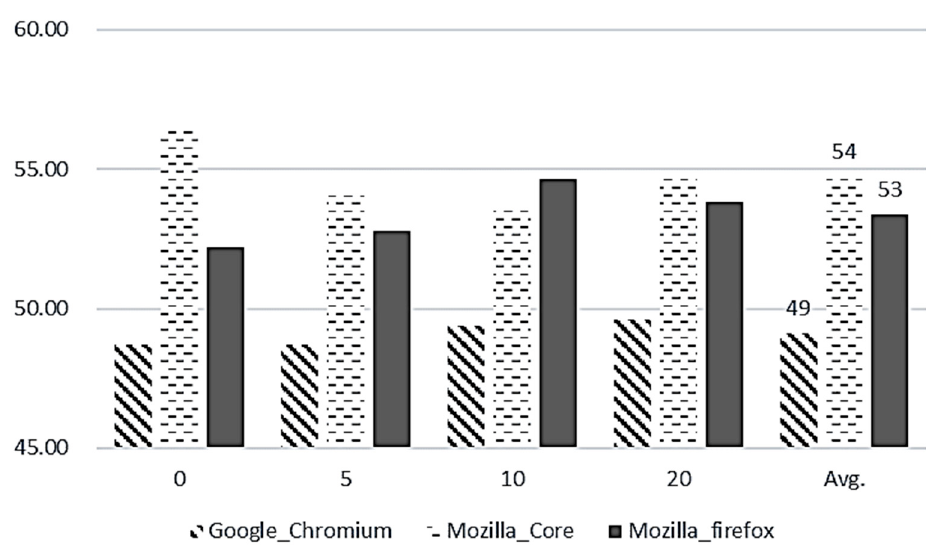
Figure 11. Accuracy result between for each project.